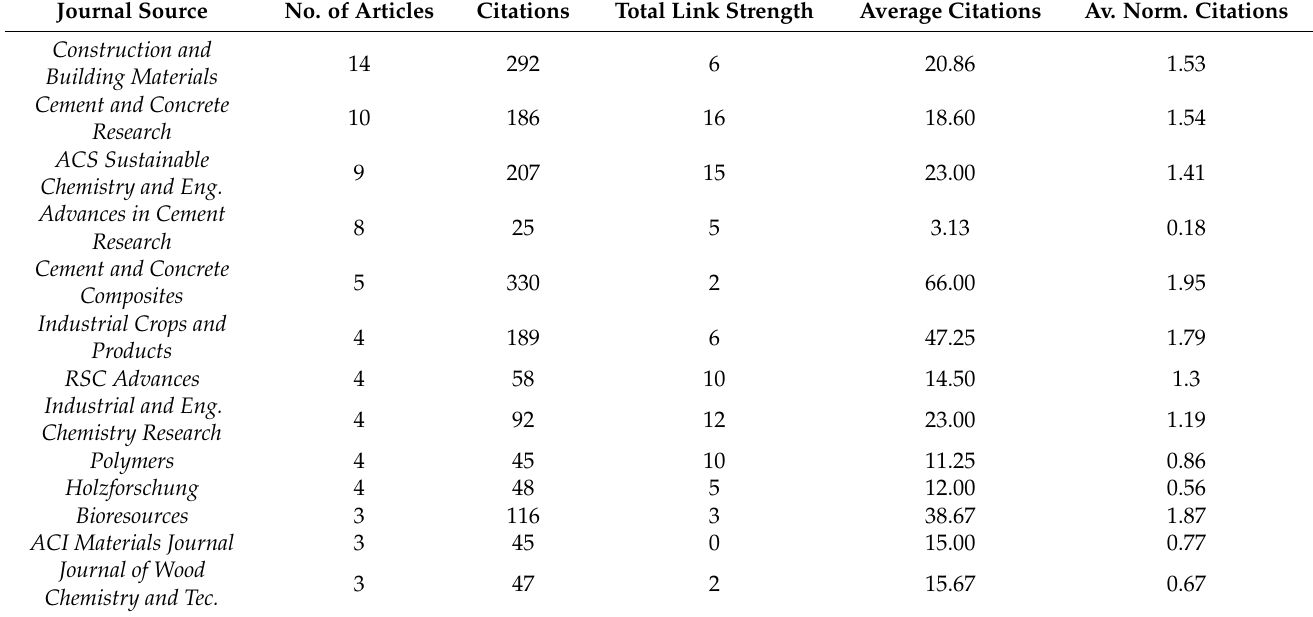
Table 1. Statistical analysis of journals in the LBAs